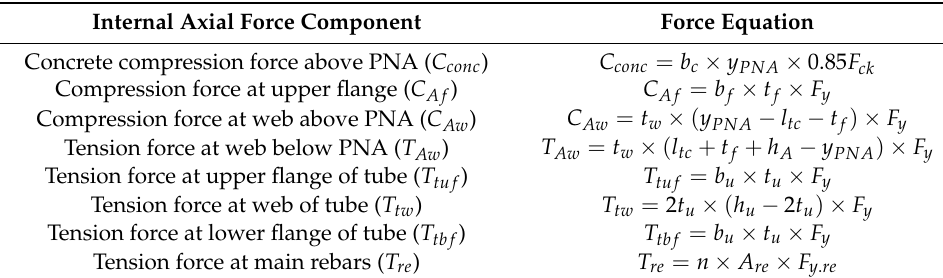
Table 9. Internal force components in case the plastic neutral axis exists below the upper flange.